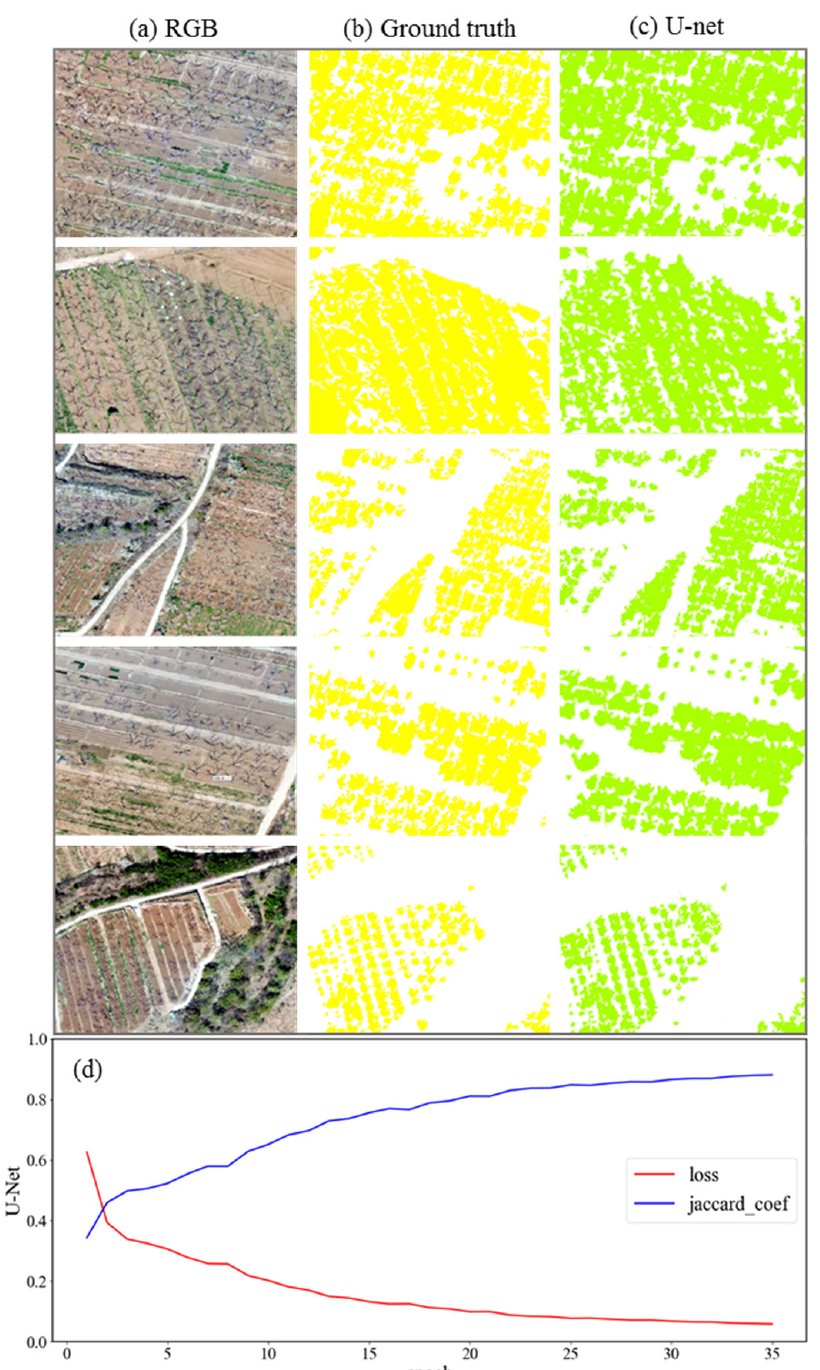
Figure 4. Comparison of the unmanned aerial vehicle (UAV) images, ground truth, and U-net algorithm recognition results for the G1 plot. ( a ) UAV red, green, and blue wavelength images, ( b ) corresponding ground truth images (yellow for peach trees and white for other areas), and ( c ) results identified by the U-net algorithm (green for peach trees and white for other areas). ( d ) Plot showing the accuracy and loss value changes for the training set with increased iterations. The Jaccard coefficient is the blue curve, and the loss value is the red curve. Table 2. Validation of the U-net algorithm identification results.